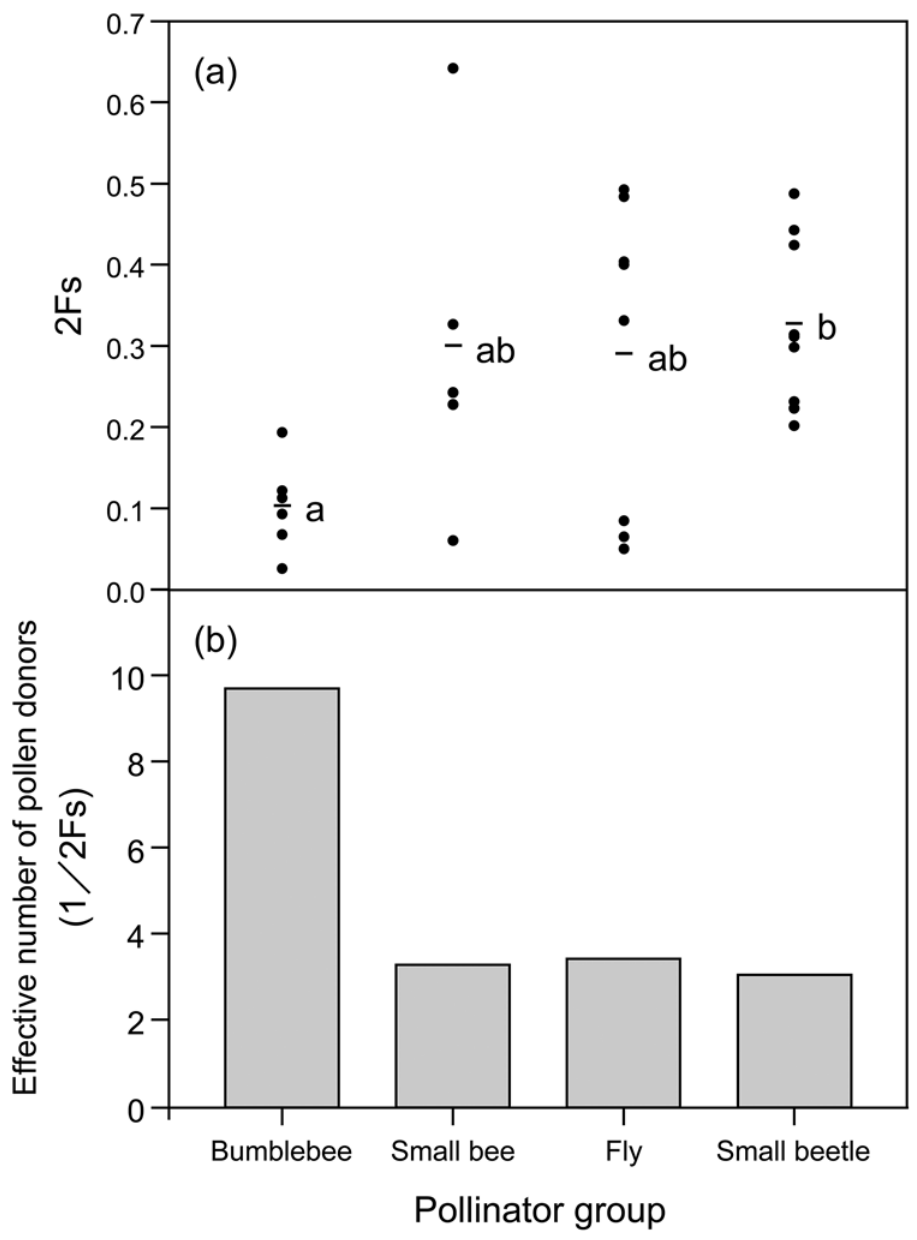
individual insect samples and the average value for each insect group, respectively. Values with different letters are significantly different at P < 0.05 (Steel – Dwass test). (b) Effective number of pollen donors was the reciprocal of the mean of correlated